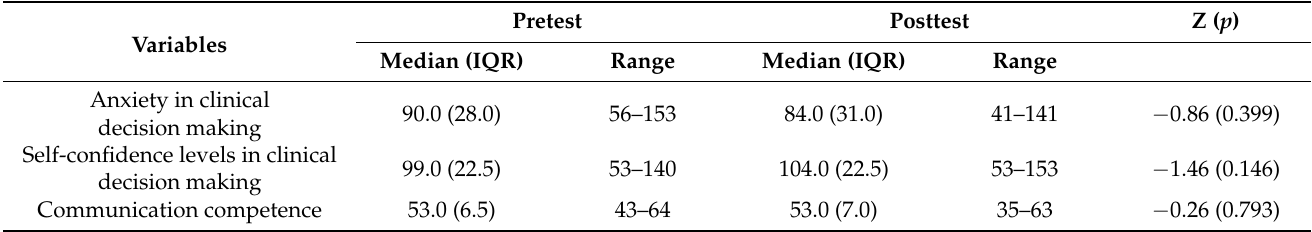
Table 2. Comparison of dependent variables between pretest and